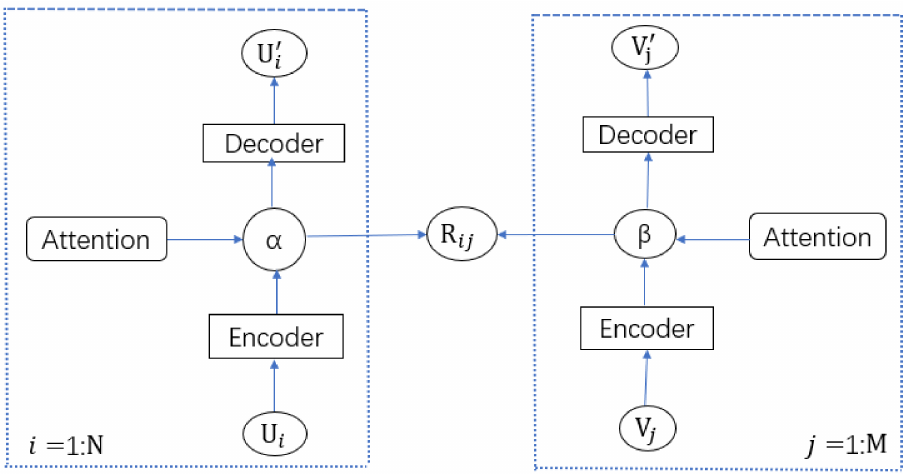
Figure 1. MAAMF model